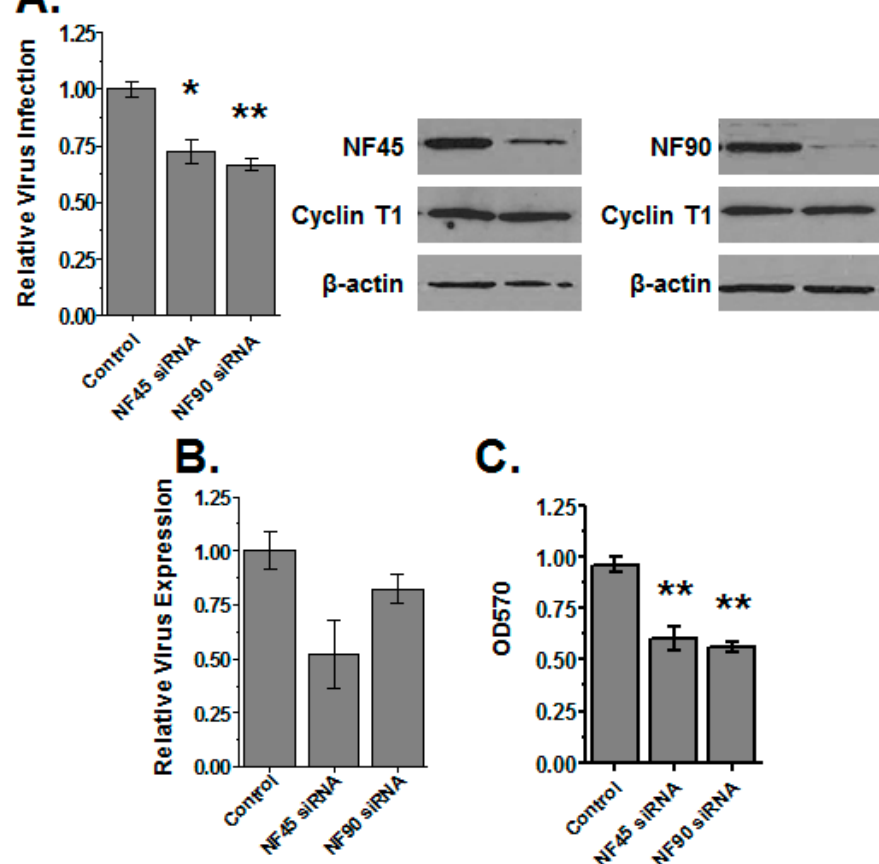
Figure 4. Knockdown studies of NF45 and NF90. ( A ) Cells were pre-transfected with small interfering RNAs (siRNAs) against NF45, NF90 or with scrambled siRNAs as a control. After 24 h cells were infected with VSVg-pseudotyped HIV-Luc reporter virus. At 24 hpi, cells were harvested and infection quantified by Luc assay and normalized to protein concentration. Knockdown was confirmed by immunoblot using β -actin as a control (panels at right); ( B ) The effect of knockdown on HIV gene expression. HIV-Luc plasmid was co-transfected with indicated siRNAs. After 24 h the cells were harvested and gene expression quantified by the amount of Luc produced relative to total protein concentration; ( C ) MTT assays. Cells transfected with siNF45, siNF90 and scramble siRNA as control were tested for viability by MTT assay after 24 h. Plots show the total data from three independent experiments with triplicate transfections; blots are representative of all three experiments.